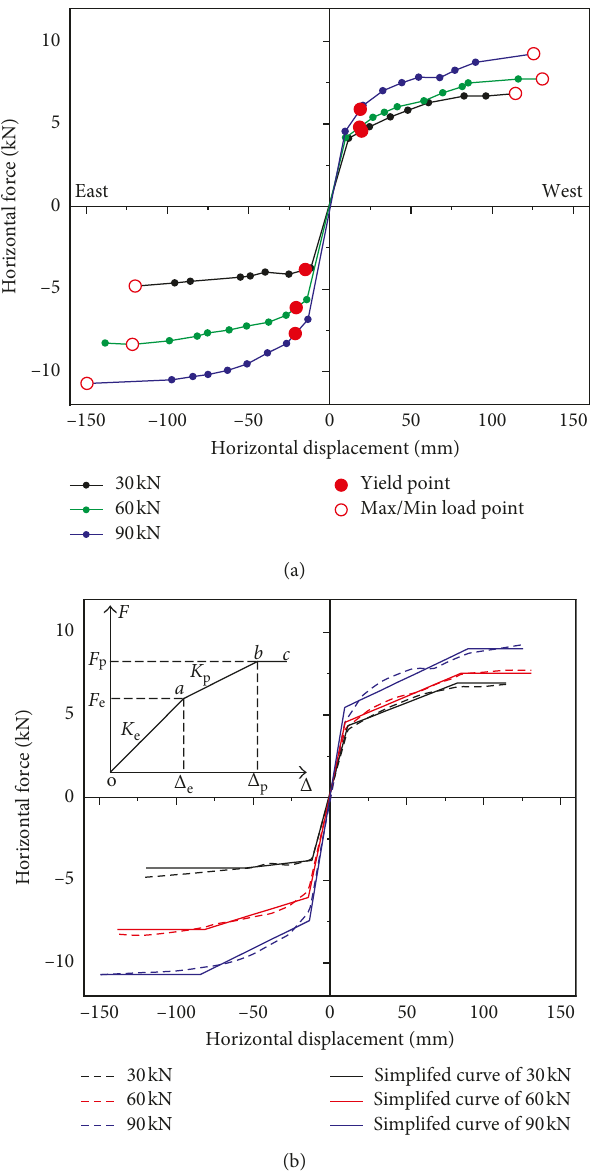
Figure 8: Skeleton curves and simplified curve with critical points. (a) Skeleton curves; (b) three-phase linear